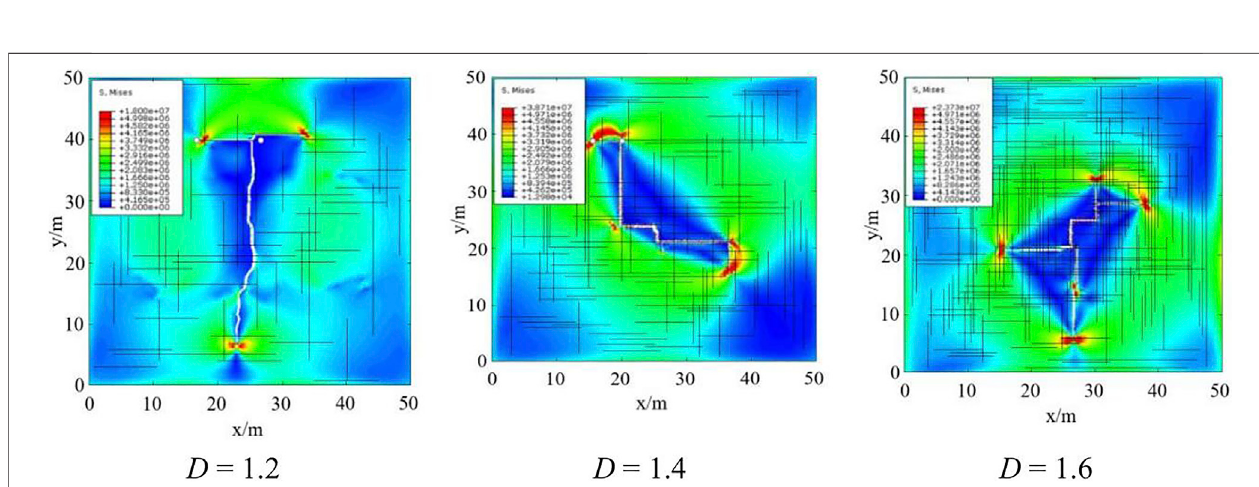
FIGURE 11 | Hydraulic fracture propagation pattern of different natural fracture dimension. D (cid:2) 1.2. D (cid:2) 1.4. D (cid:2) 1.6.